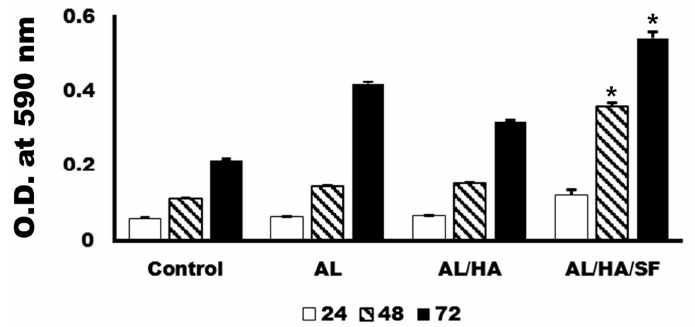
Figure 3. 3-(4,5-Dimethylthiazol-2-Yl)-2,5-diphenyltetrazolium bromide (MTT) assays for MG63 cells